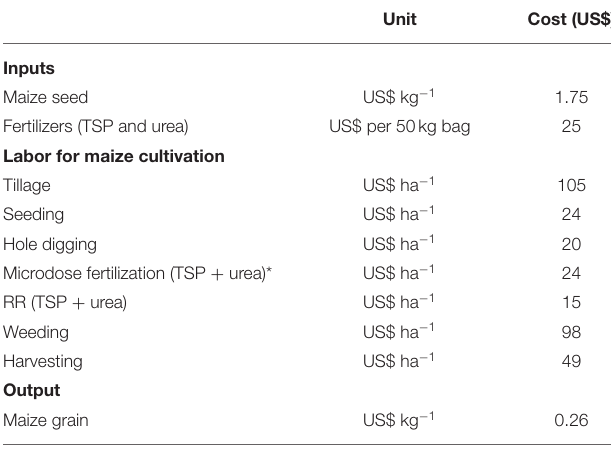
TABLE 2 | Input and output prices used in the economic analysis.